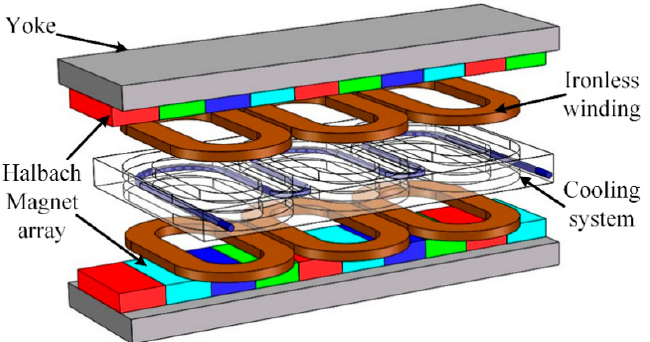
Figure 13. Novel ironless linear synchronous motor with cooling system. Reprinted with permission from ref. [86]. Copyright 2016 MDPI.